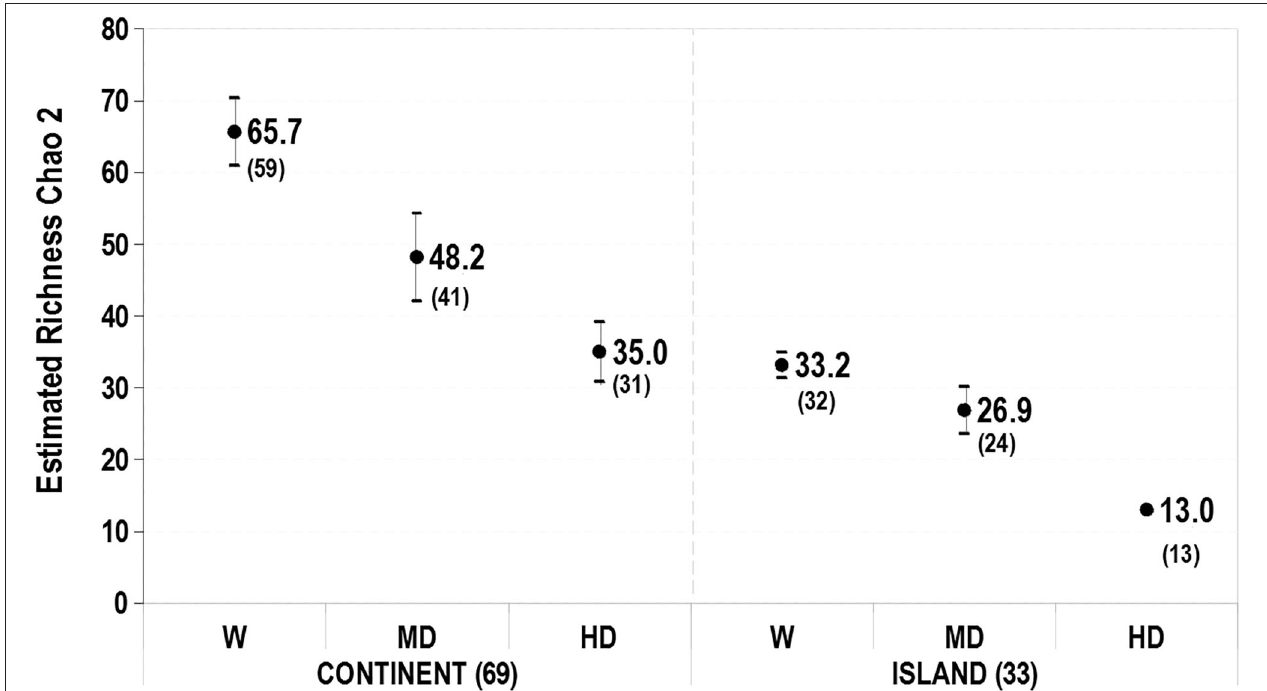
FIGURE 1 | The estimated richness of bird species (Chao 2 index), in the three types of urban habitats in Continent and Island. Total species observed in parenthesis. Vertical bars represent SD. W, remnant woodland; MD, medium density; HD, high density.